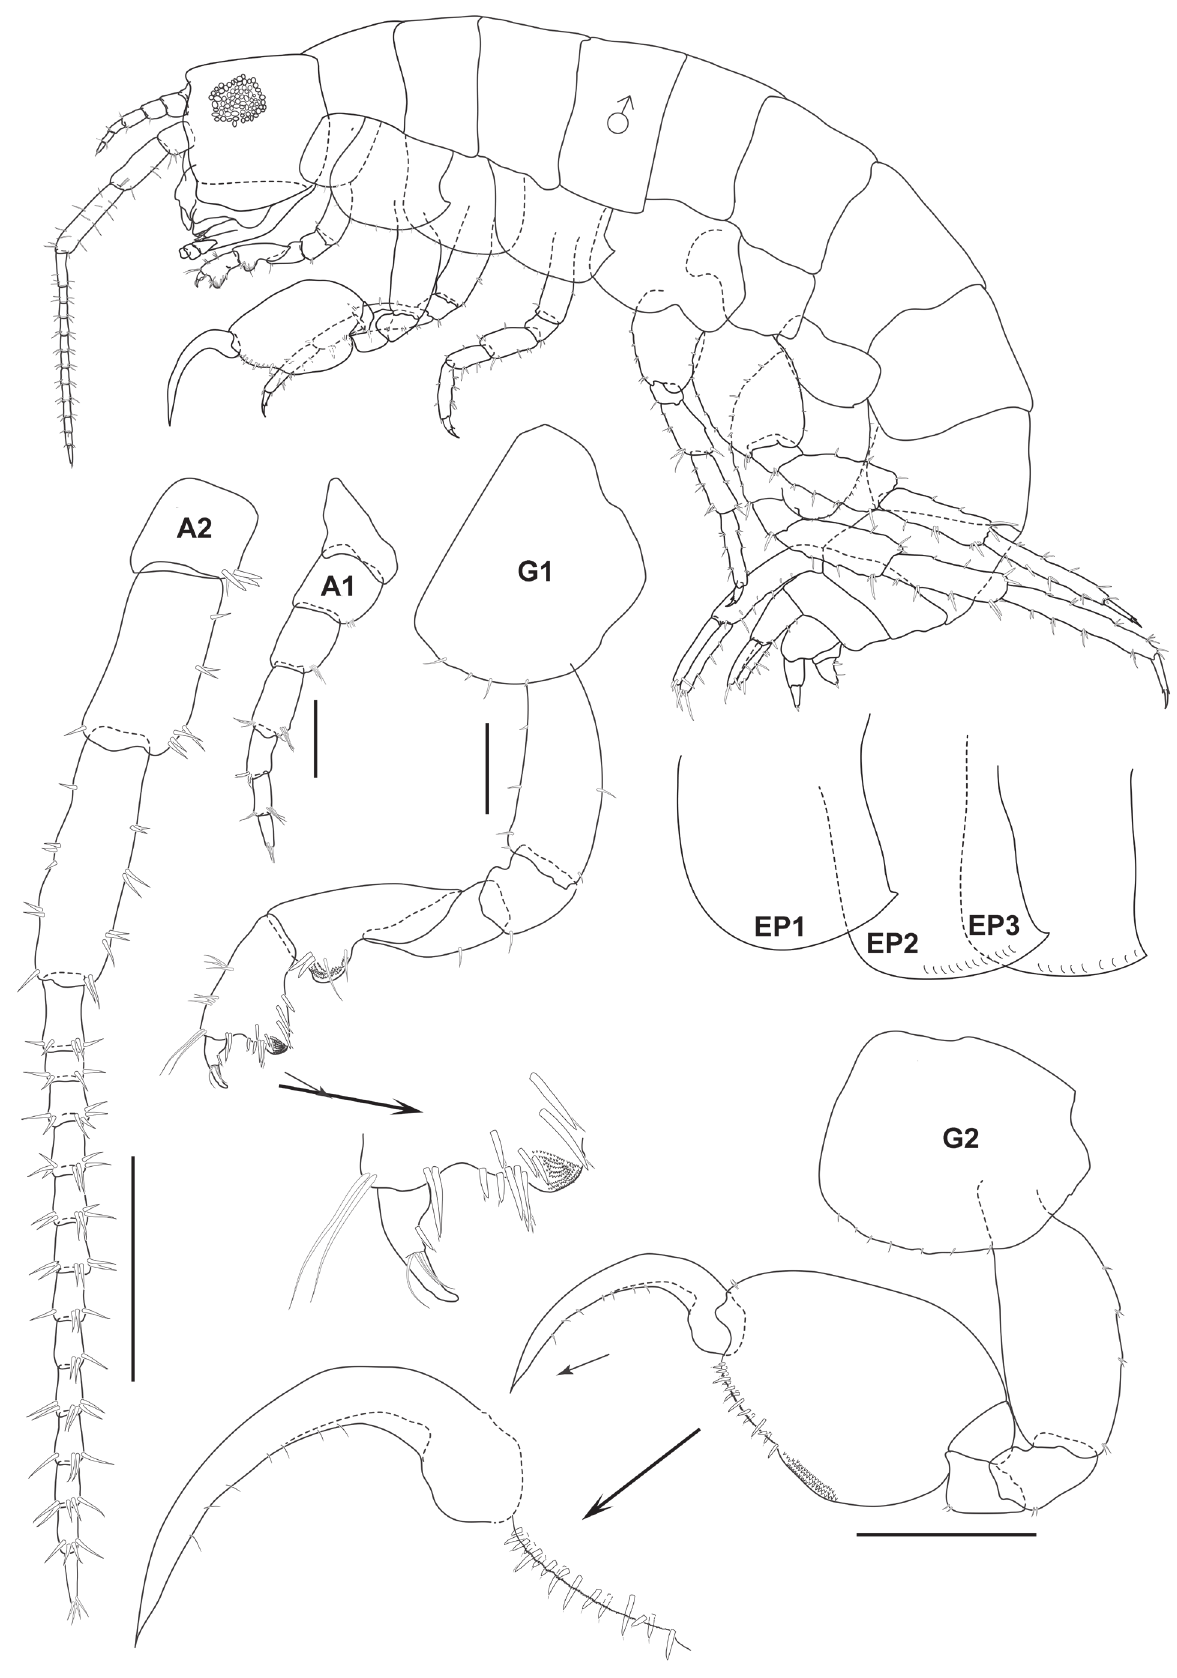
Figure 7. Floresorchestia s amroiyodensis sp. n., allotype, male, (PSUZC-CR-0274) 10.5 mm. Khao Sam Roi Yod National Park. Scales for A2 and G2 represent 0.5 mm; A1, G1 represent 0.2